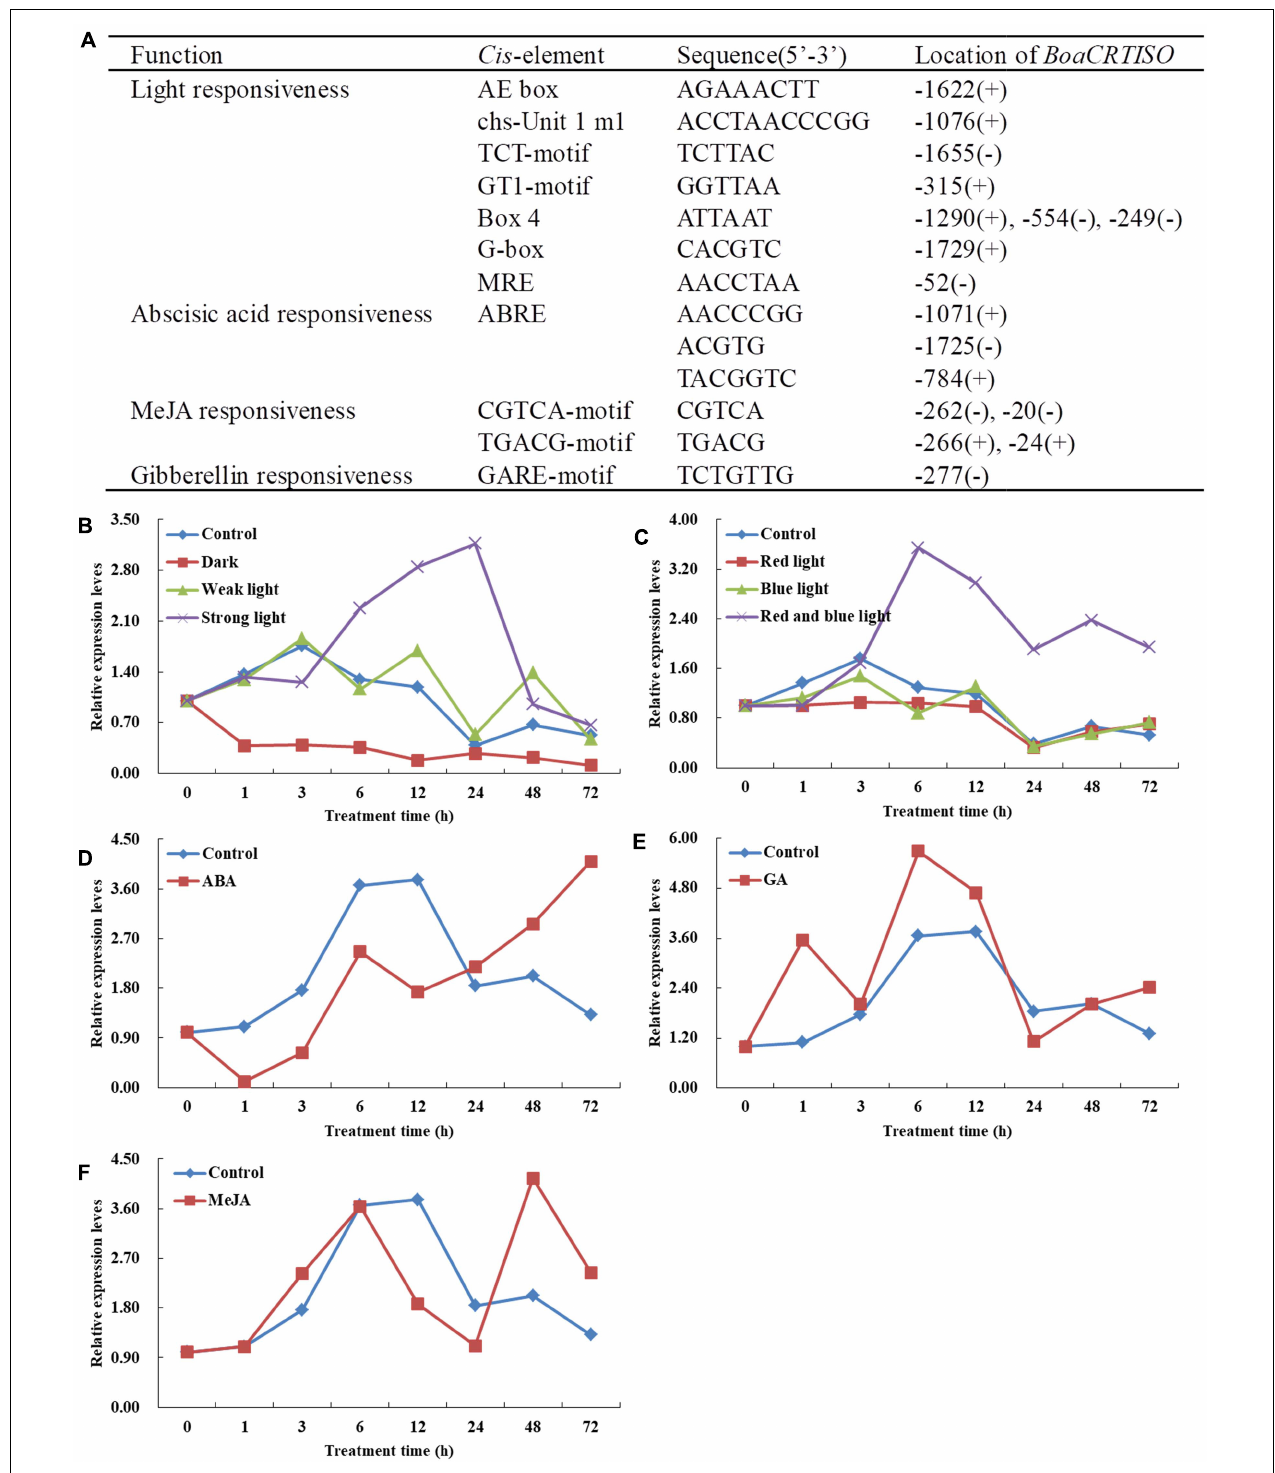
FIGURE 3 | Response of BoaCRTISO to different exogenous treatments. (A) Cis -acting elements respond to light and phytohormone in the promoter regions of BoaCRTISO . The + and − in brackets represent sense strand and antisense strand, respectively. (B) Expression levels of BoaCRTISO after treatments with darkness, weak light, and strong light. (C) Expression levels of BoaCRTISO after treatments with red light, blue light, and combined red and blue lights. (D) Expression level of BoaCRTISO after abscisic acid (ABA) treatment. (E) Expression level of BoaCRTISO after GA 3 treatment. (F) Expression level of BoaCRTISO after methyl jasmonate (MeJA)